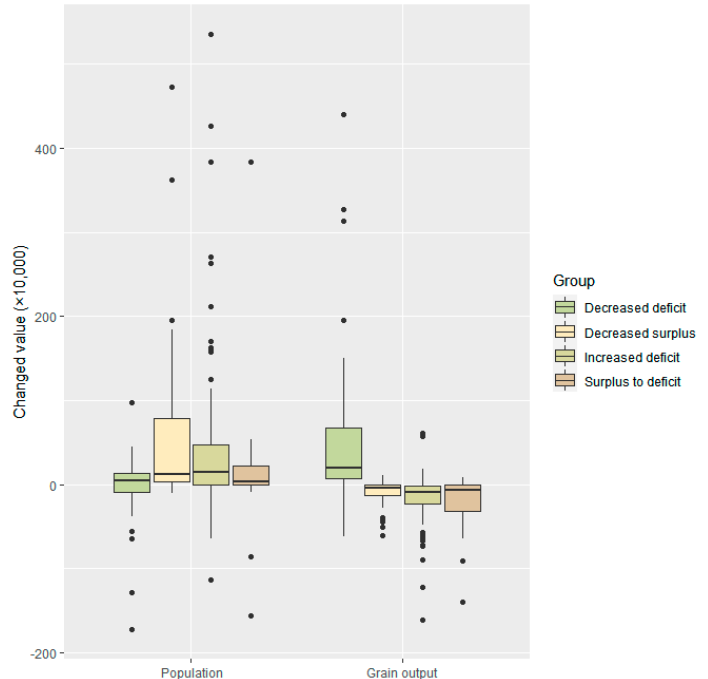
Figure 3. Variation of the total population and grain output. The vertical axis indicates the variation of the aggregate population and grain output from 2008 to 2018. In a boxplot, the horizontal line inside the box indicates the average and the height of the box indicates the interquartile range including 50% of the overall points.